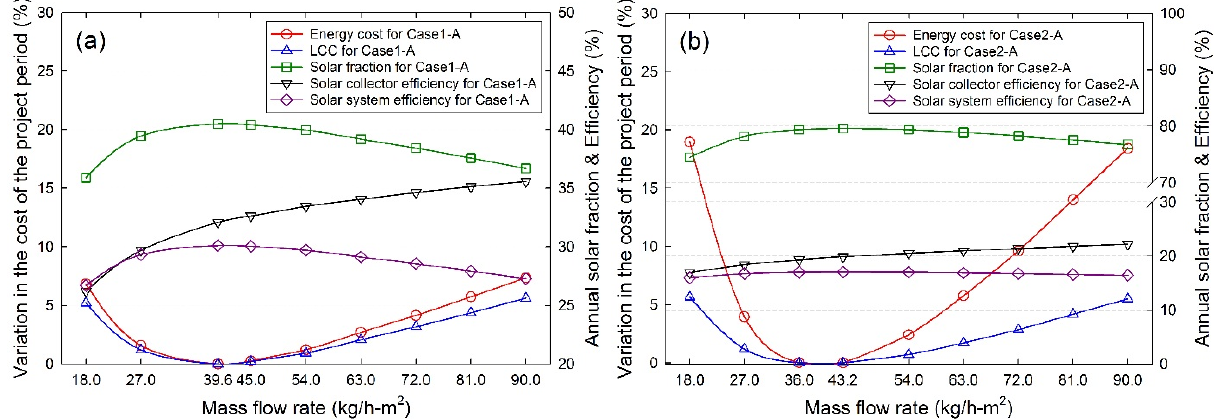
Figure 10. Effect of mass flow rate per unit area of the collector on the energy and economic performance of the SWH systems: ( a ) Case1-A and ( b )